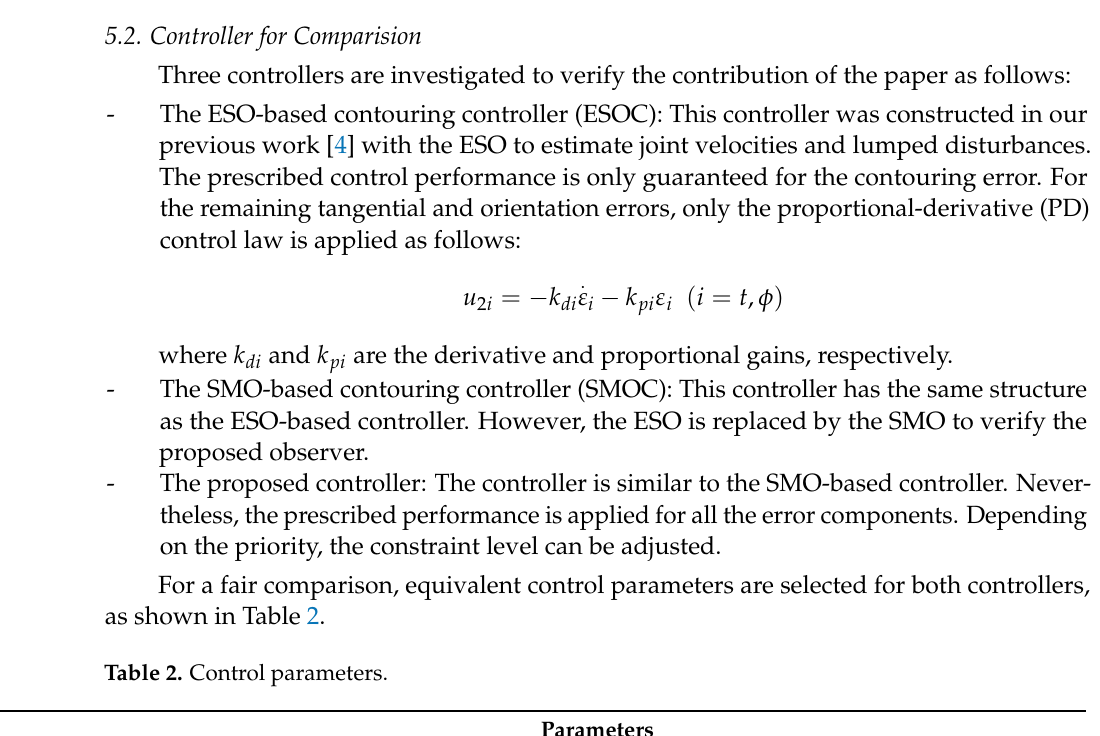
Figure 4. Investigated robotic excavator model [4], Reprinted/adapted with permission from Ref. [4]. 2021, Elsevier.